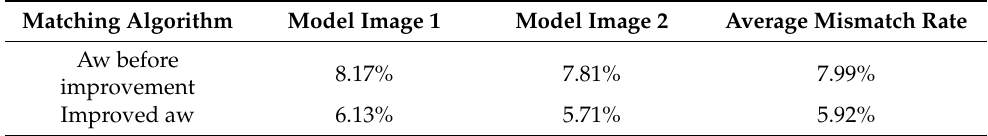
Table 3. Error-matching rate of adaptive weight before and after